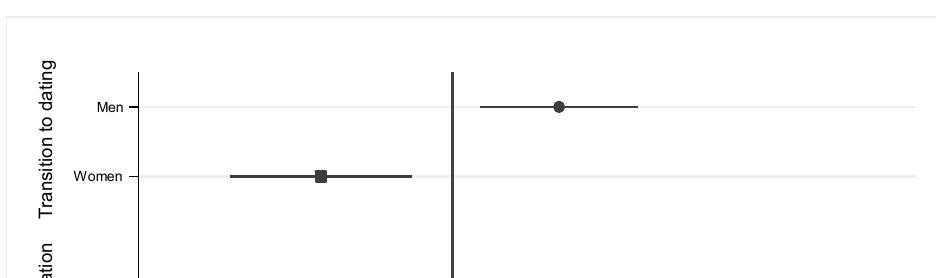
Figure 4 : Overview main effects unit transitions based on Model 1, Model 3, and Model 5 (90 %